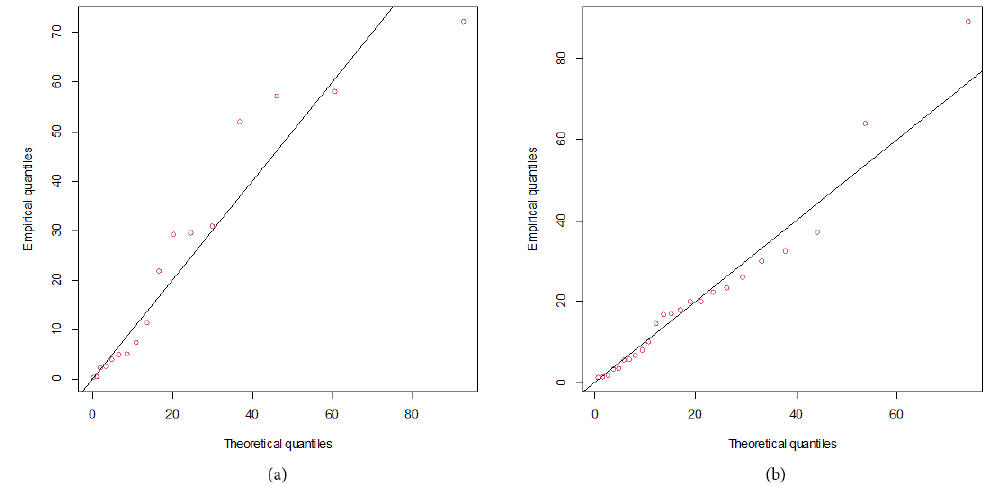
Figure 8. Q-Q plots for distribution fitting of the positive rainfall data from the Rong Kwang district station, Phrae province, Thailand, for ( a ) January from 1969–2021 and ( b ) February from 1953–2021. Table 5. The 95% two-sided confidence intervals for the ratio of variances of rainfall datasets from